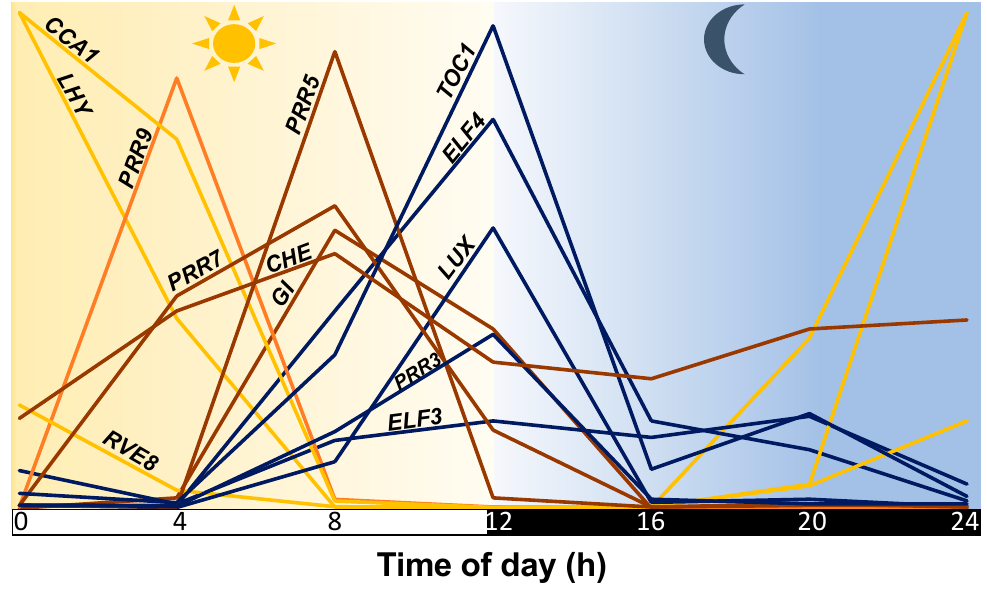
Figure 1. Timing of the peak expression of primary circadian clock components. Represented are normalized expression profiles obtained from DIURNAL, using experimental conditions LDHH_SM and LDHH_ST [29].